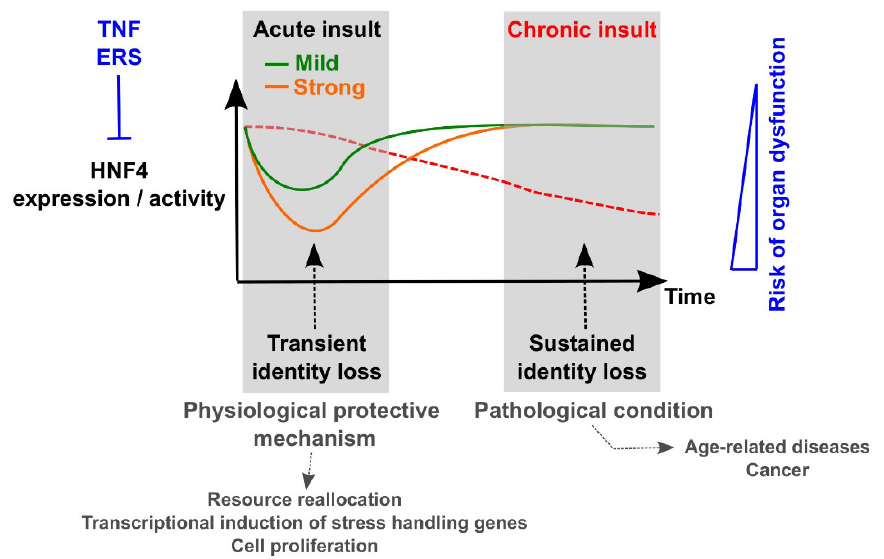
Figure 2. Proposed relationship between strength and duration of organ insults and HNF4-mediated control of cell identity. Acute injury triggers loss of HNF4 transcriptional activity through decreased expression and / or chromatin recruitment, with the degree of the inhibition correlating with the severity of the insult. HNF4 loss is accompanied by a shutdown of cell identity, partly attributable to a collapse of the TF networks controlling identity gene expression. This loss is transient (i.e., expression of HNF4 and other identity TFs is re-established once the stress resolves) and seems to be a protective mechanism to cope with the acute insult in the context of reallocation of transcriptional resources. However, when the insult persists leading to chronic stress / injury, repression of HNF4 and cell identity endures, which might precipitate accompanying organ dysfunction and occurrence of cancer.